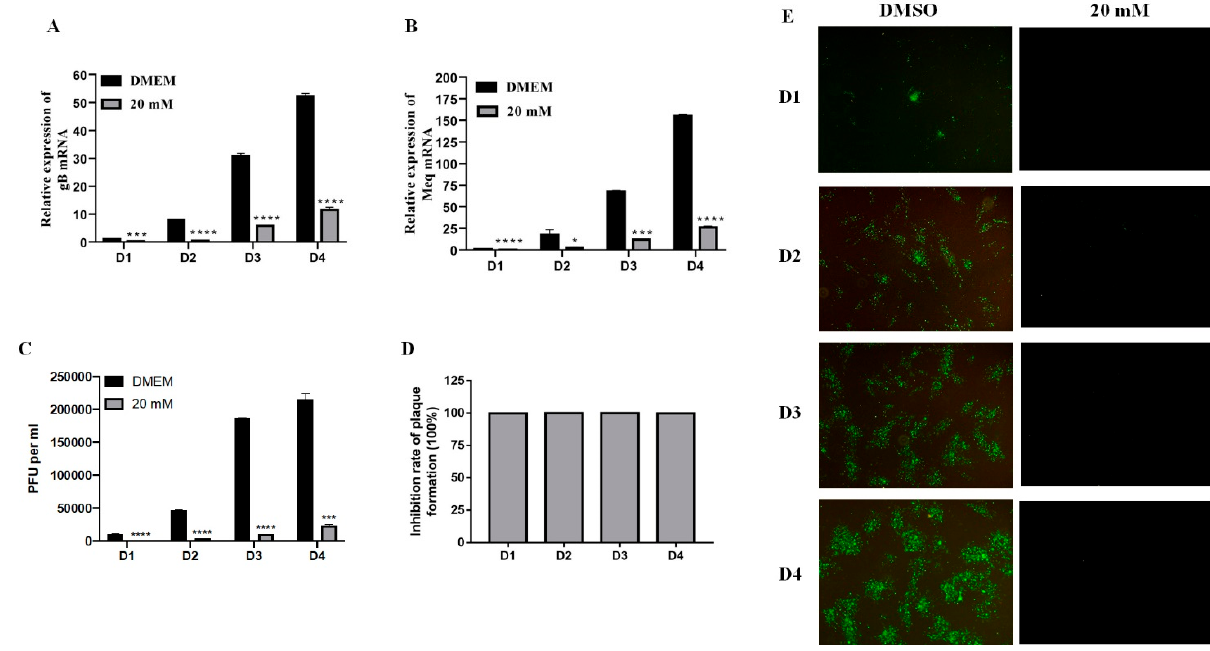
Figure 2. The inhibitory effect of LiCl on MDV replication in CEF is time-dependent. Total RNA was extracted from day 1 to day 4 after virus infection, and the expression levels of gB gene ( A ) and Meq gene ( B ) were detected by RT-qPCR. ( C ) Plaque count of MDV RB-1B strain infected CEF treated with 0 and 20 mM LiCl at different time points. ( D ) The inhibition rate of plaque was calculated and presented as mean plaque titers relative to the DMSO group. The mean plaque titer of the DMSO group was set to 100%. ( E ) Virus plaque formation was directly observed by indirect immunofluorescence assay at day 1 to day 4 after virus infection. The pictures were captured with an OLYMPUS microscope ( × 200). The data are expressed as the mean ± SD of three independent experiments, and analyzed by Student-t Test (* p < 0.05, *** p < 0.001, **** p < 0.0001) for A, B, and C.